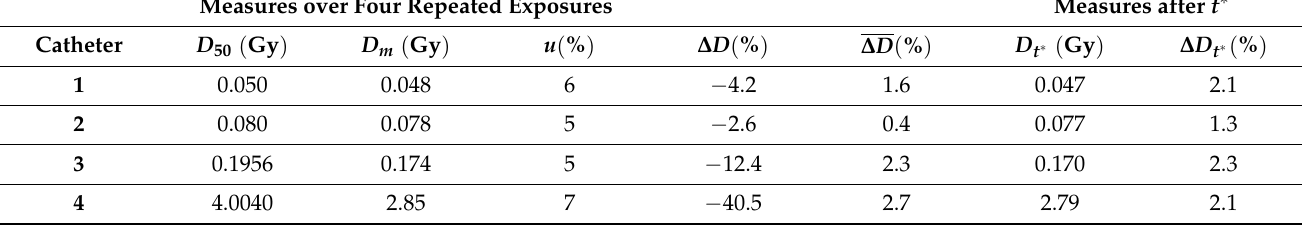
Table 6. D m over four subsequent exposures compared to TPS calculated dose D 50 (left) and measured doses D m for a single exposure performed after 1 week (right) for the plan with a single active position in C4. The relative standard uncertainty u (%) with k = 2 is also shown along with percent differences. Measures over Four Repeated